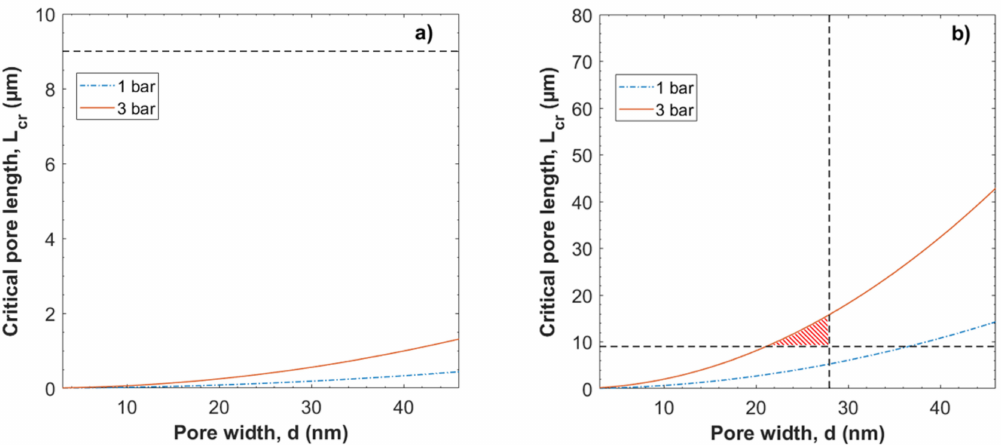
Figure 5. Critical pore length L as a function of pore width d , i.e., u = u cr , for ( a ) 5 nm gold particles and ( b ) Φ X174 bacteriophages at pressures 1 and 3 bar. Dashed lines at L cr = 9 µ m and d = 28 nm indicate filter thickness and diameter of the Φ X174 bacteriophage respectively; Highlighted areas in ( b ) indicate pore lengths and widths where hydrodynamic constraint is